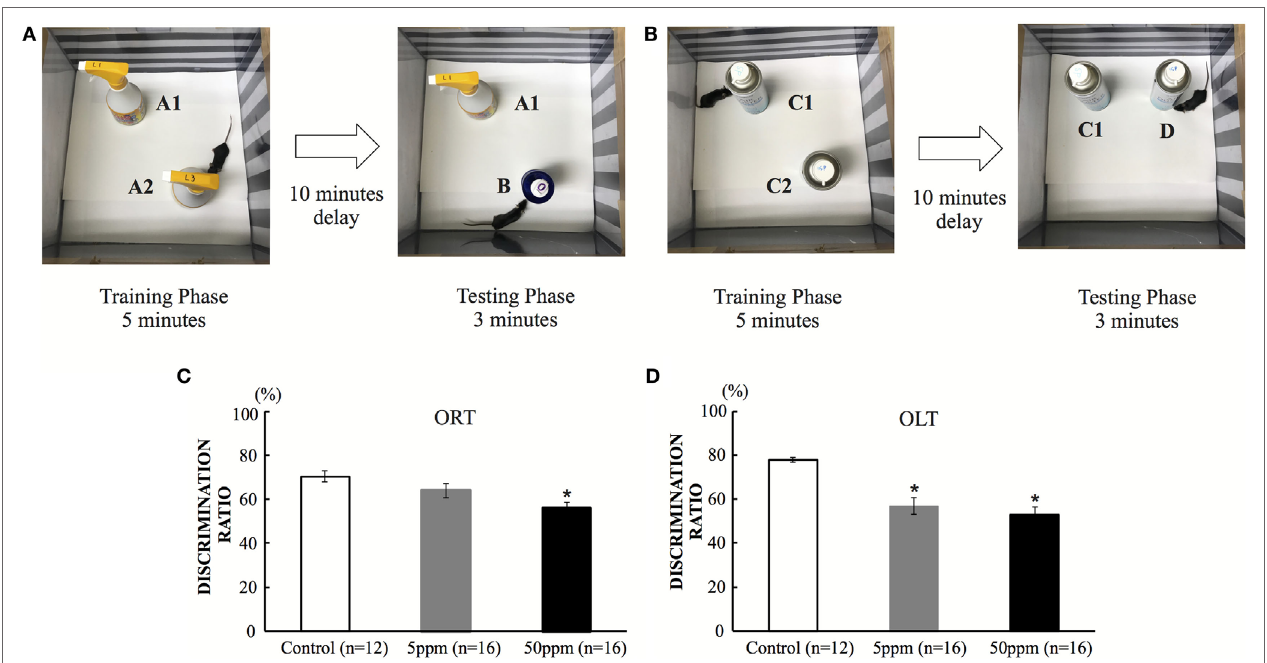
FigUre 4 | The effect of propylthiouracil treatment during in utero and postnatal periods in object recognition test (ORT) and OLT. (a) ORT apparatus. A mouse was put in the box and was introduced to two identical objects (Object A1 and A2). In the test phase, one object was replaced by a novel object (Object B). (B) OLT apparatus. A mouse was put in the box and was introduced to two identical objects (Object C1 and C2). In the test phase, one object was displaced to a new location (Object D). (c) Discrimination ratio of object recognition in ORT. The ratio decreased significantly in the 50 ppm group, indicating that the mice could not recognize the novel object. Data are the mean ± SEM, * p < 0.05 compared with the control group by the Bonferroni test. (D) Discrimination ratio of object-in- location in OLT. The discrimination ratio decreased significantly in the 5 and 50 ppm groups. Data are mean ± SEM, * p < 0.05 compared to the control group by Bonferroni